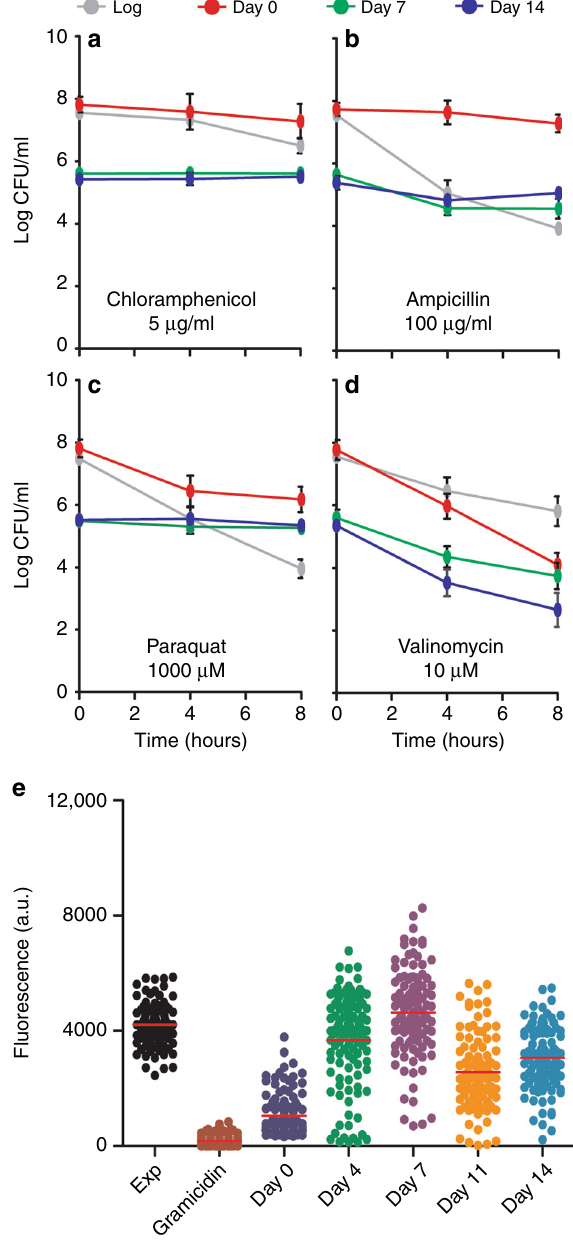
Fig. 3 Antibiotic sensitivity under starvation conditions. Cultures of Δ spoIIE were set up in accordance with the starvation assay. Samples were taken from cultures at days 0, 7, and 14, and treated with either: a 5 µ g ml − 1 chloramphenicol, b 100 µ g ml − 1 ampicillin, c 1 mM paraquat, or d 10 µ M valinomycin, for 8 h. As a control, exponential phase cells were treated in the same manner as the starvation samples (gray lines). Graphs show the average and standard deviation of three independent experiments. e Membrane potential levels of cells after 0, 4, 7, 11, and 14 days ’ deep starvation. Relative membrane potential levels were determined based 3,3 ′ -dipropylthiadicarbocyanine iodide. As controls, membrane